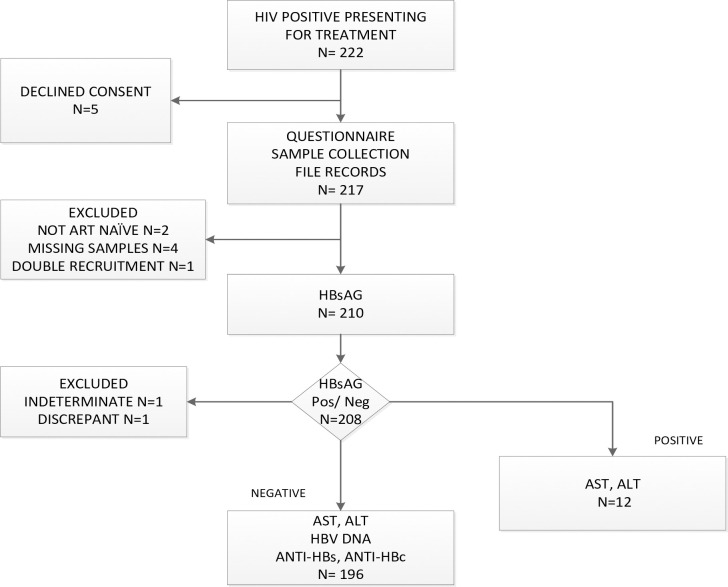
Study Flow of recruitment and testing.